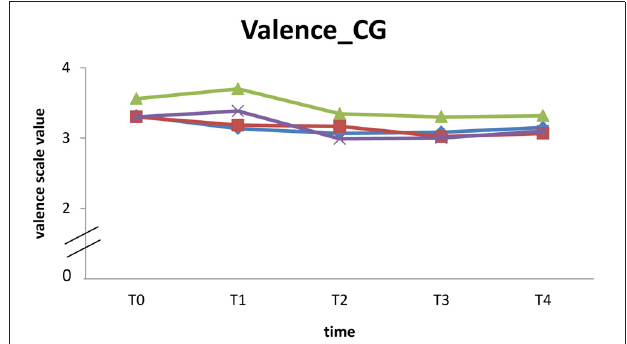
FIGURE 3 | Individual trend of valence from T0 to T4 of participants ( CG ) with good